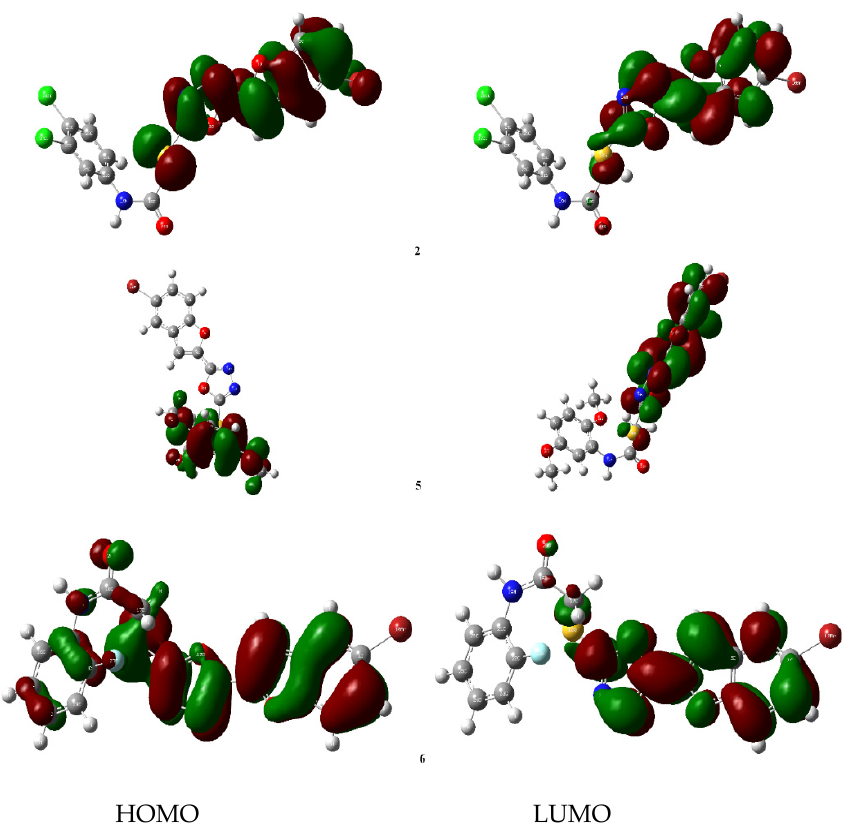
Figure 12. The HOMO (left) and LUMO (right) tube orientations of molecular orbitals of com- pounds BF-2 , BF-5, and